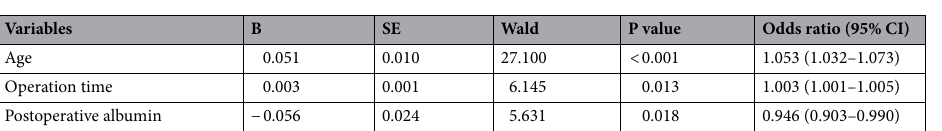
Table 5. Multivariate logistic regression analysis of risk factors influencing postoperative pulmonary imaging abnormalities in the patients underwent craniotomy for brain tumor. Adjusted for age, diabetes mellitus, history of stroke, red blood cell, red blood cells, postoperative hemoglobin, postoperative hematocrit, postoperative fibrinogen, postoperative glucose, postoperative magnesium, postoperative prealbumin, postoperative total protein, postoperative albumin/globulin ratio. B regression coefficient, SE standard errors of regression coefficient.